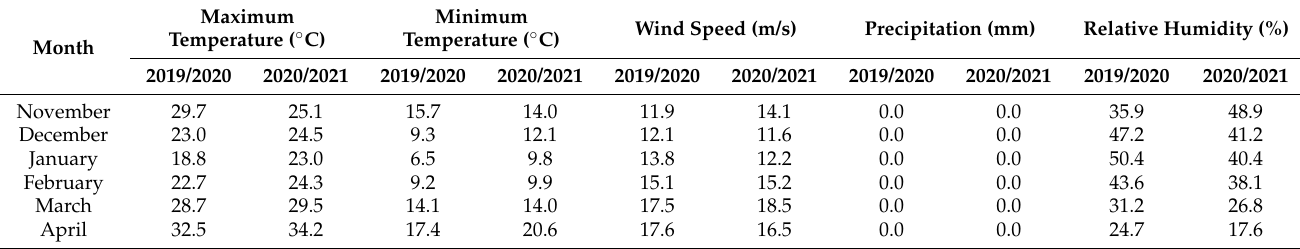
Table 1. The average data of monthly maximum and minimum temperature, wind speed, and relative humidity during the two growing seasons. Maximum Temperature ( ◦ Month